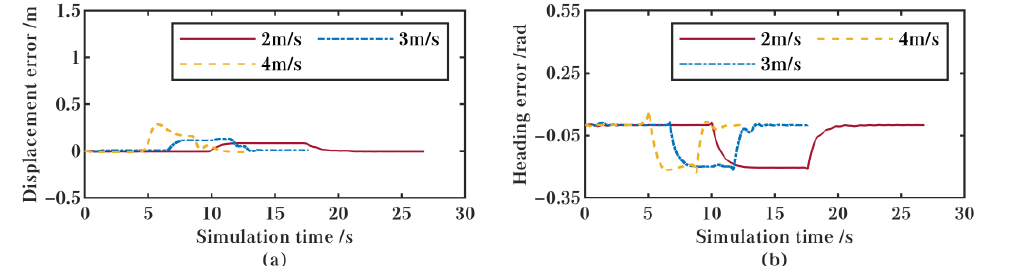
Figure 10. The errors of the simulation at different speeds: ( a ) the displacement error; ( b ) the heading error.